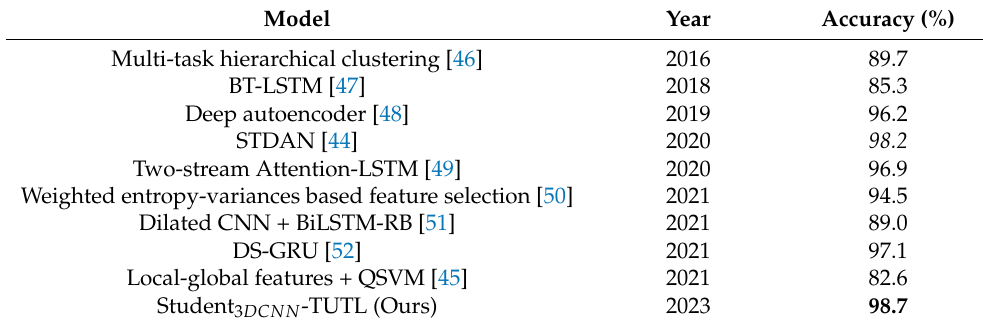
Table 7. Quantitative comparative analysis of our proposed framework with the state-of-the-art action recognition methods on UCF11